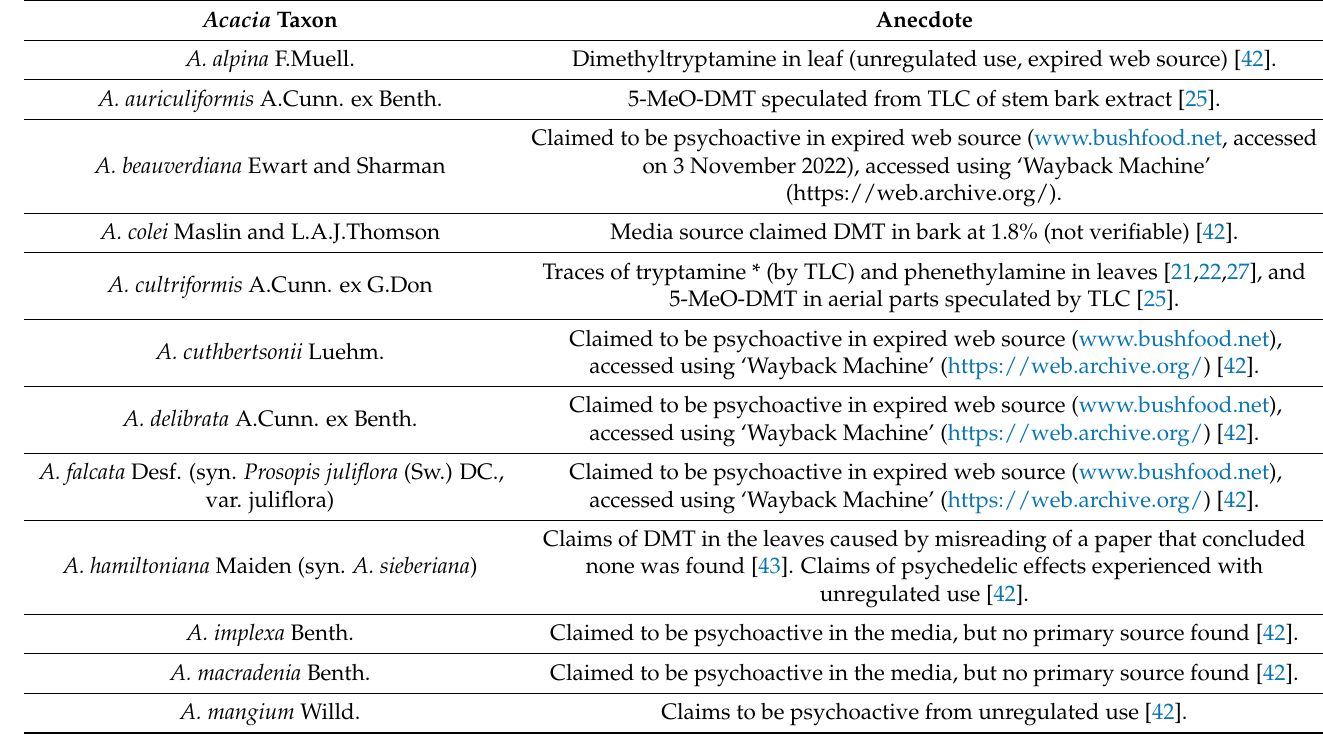
Table 2. Australian species of Acacia with anecdotes of psychotropic effects or psychotropic alkaloids that have not been verified by the author or in a peer reviewed